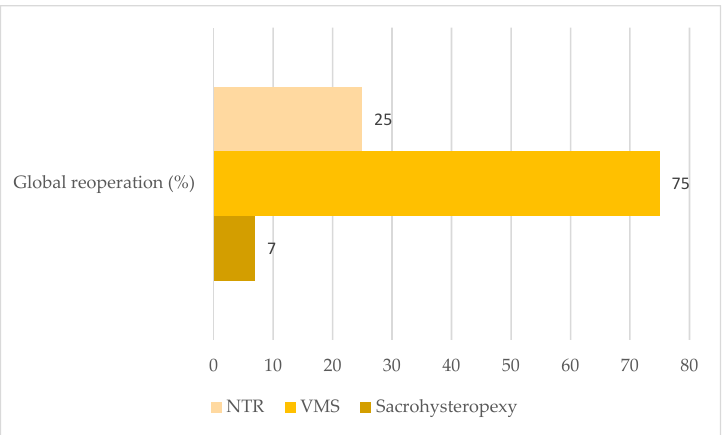
Figure 2. Long-term POP recurrence after a POP repair in women under 40 years old according to the surgical technique. POP: pelvic organ prolapse; VMS: vaginal mesh surgery; NTR: native tissue repair by vaginal route.